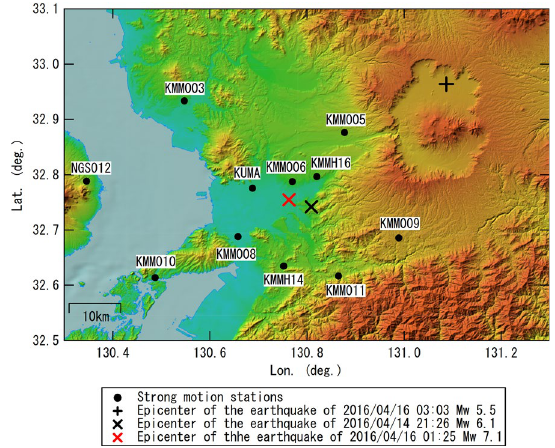
Fig. 1 Locations of target earthquakes and sites used in the simulations. Black dots indicate the target sites. Black plus sign and black and red crosses indicate the epicenters of the earthquakes of 2016/04/16 03:03 ( M w 5.5), 2016/04/14 21:26 ( M w 6.1), and 2016/04/16 01/25 ( M w 7.1),